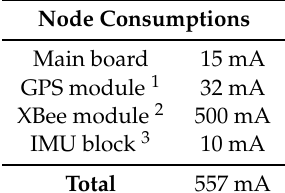
Table 2. Energy consumption of the measurement